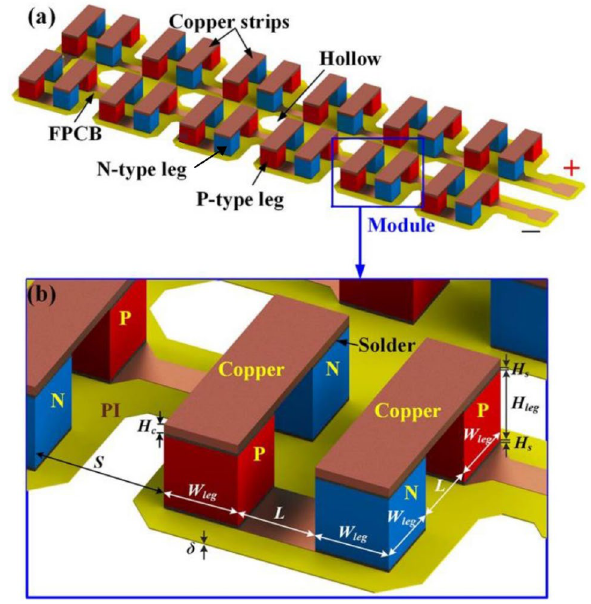
Fig. 1 Structural design of wearable thermoelectric harvesting device: a schematic view; b close-up view of one thermoelectric module. Adapted with permission from Ref.[12]. Copyright 2018